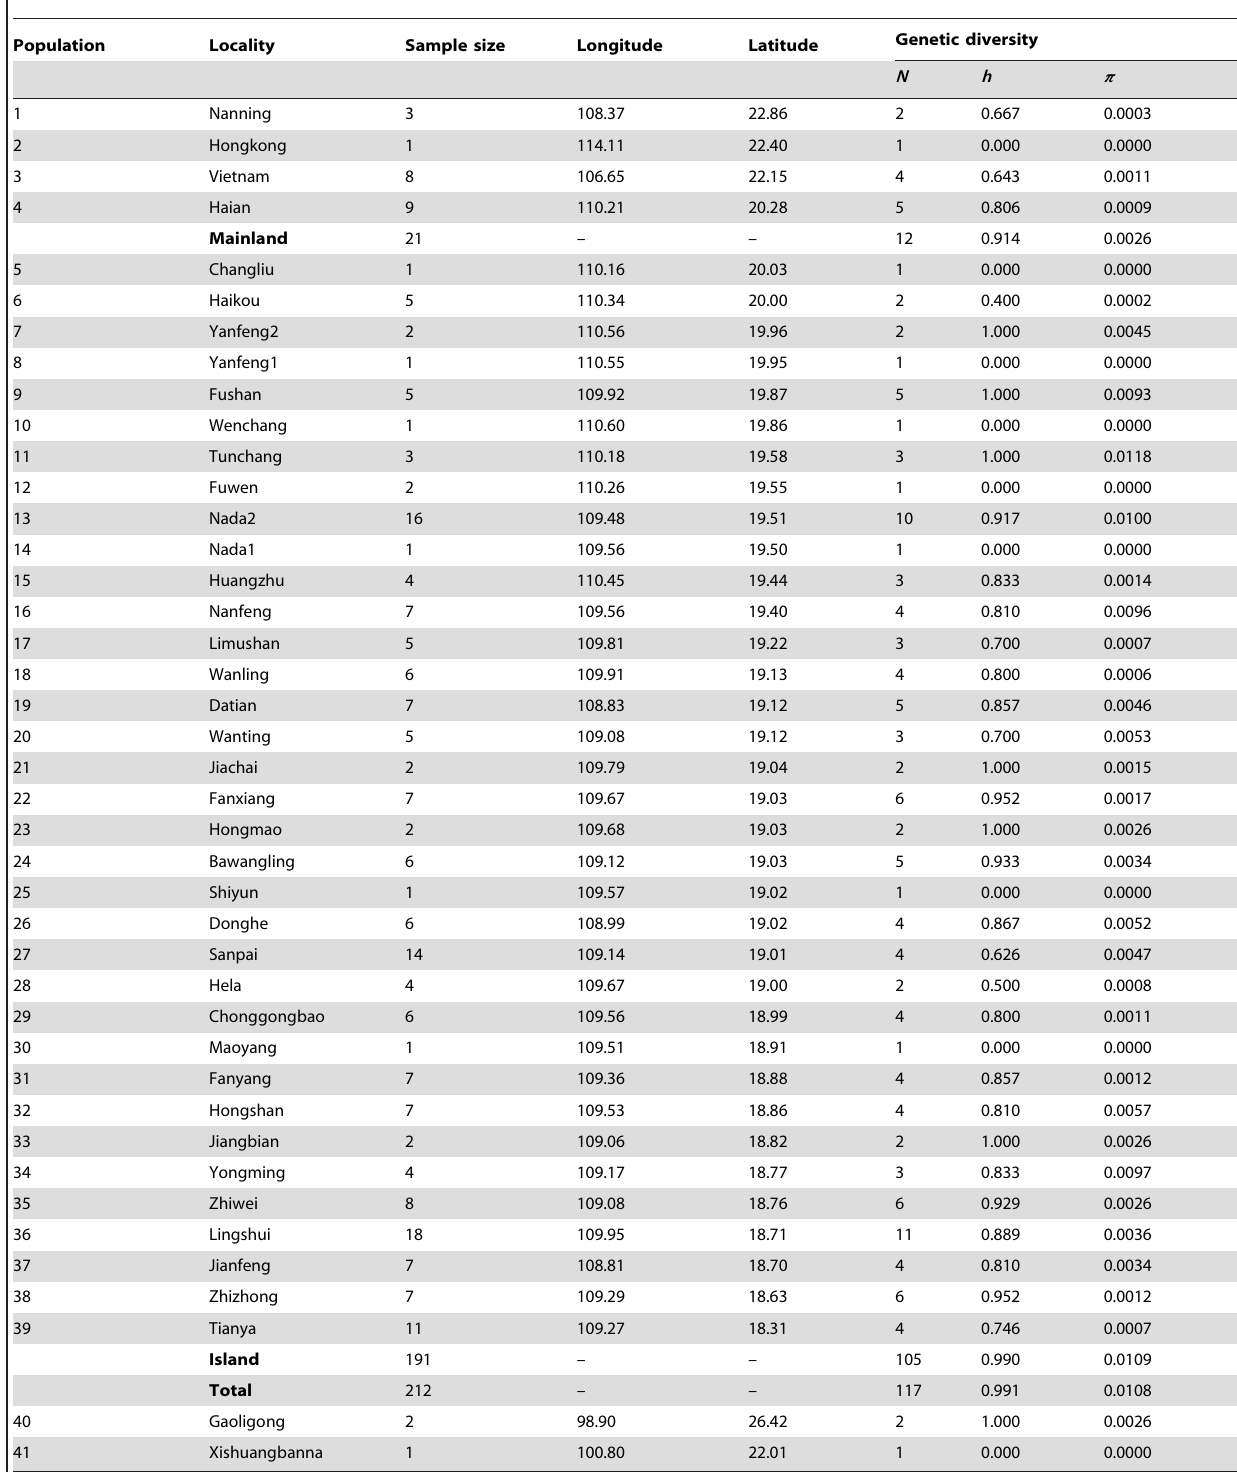
Table 1. Sample localities, sample sizes, number of haplotypes ( N ), haplotype diversity ( h ), and nucleotide diversity ( p ) for Calotes versicolor